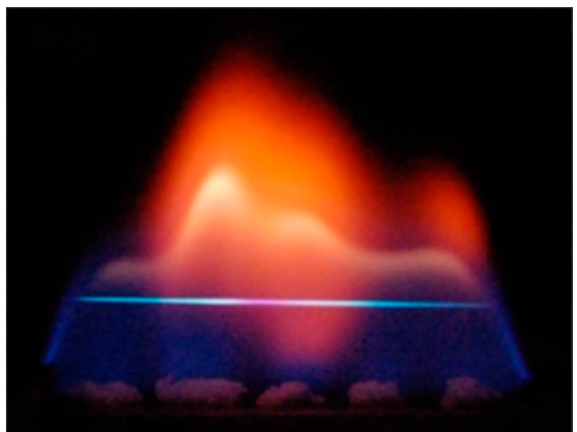
Figure 5. The photo of the flame on the alcohol burner array together with the femtosecond laser-induced filament [108]. (Reproduced from Chu W., Li H., Ni J., Zeng B., Yao J., Zhang H., Li G., Jing C., Xie H., Xu H.; Yamanouchi K, and Cheng Y, Lasing action induced by femtosecond laser filamentation in ethanol flame for combustion diagnosis, with the permission of AIP Publishing).